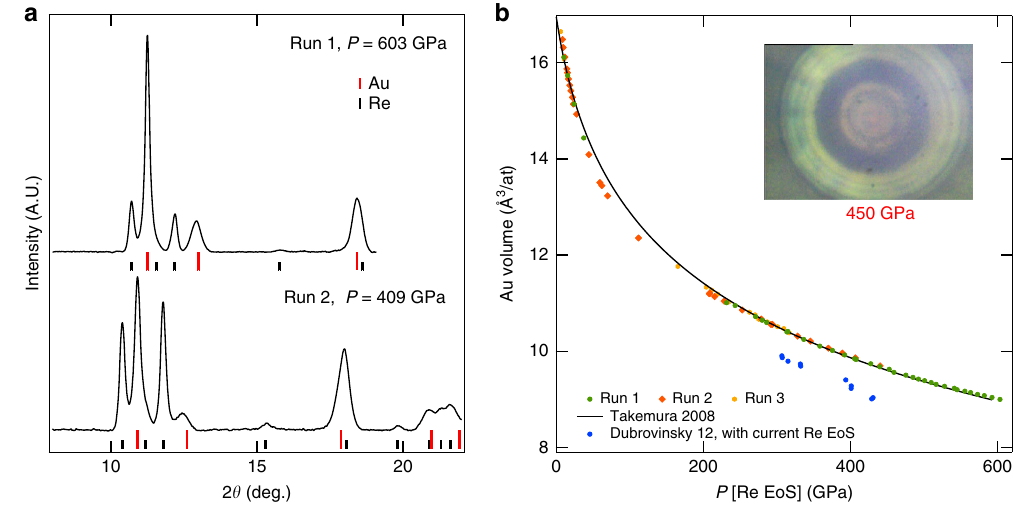
Fig. 3 Gold equation of state data. a XRD spectra collected at the center of the pressure chamber for runs 1 and 2. The exposure time was 20 s. The red and black ticks indicate the positions of the XRD peaks of gold and rhenium, respectively. The (002) peak of gold is slightly shifted from its tickmark under the effect of deviatoric stress (see text). b Volume of gold measured up to 603 GPa in runs 1 – 3. It is based on the (111) diffraction line position, which is the least affected by non-hydrostatic stress 37 . The pressure is estimated using rhenium gasket equation of state 35 . The black continuous line is the quasi- hydrostatic equation of state of gold, measured up to 131 GPa 39 and extrapolated here up to 600 GPa using the Rydberg – Vinet form. The blue dots are joint measurements of Au and Re lattice parameters in the ds-DAC 18 , converted to Au equation of state data points similarly to our data points. Inset: photograph of the sample chamber taken at 450 GPa in run 1